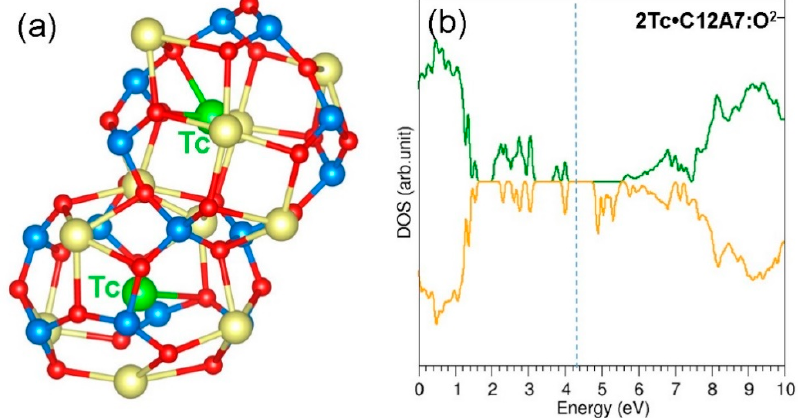
Figure 3. ( a ) Relaxed cages containing two Tc atoms in C12A7:O 2 − and ( b ) DOS plot calculated for 2Tc: C12A7:O 2 −